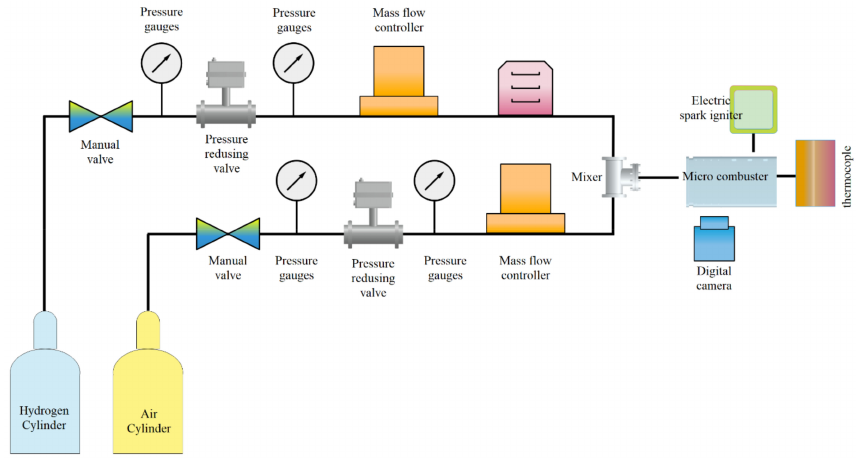
Figure 25. Schematic diagram of the experimental system [231].